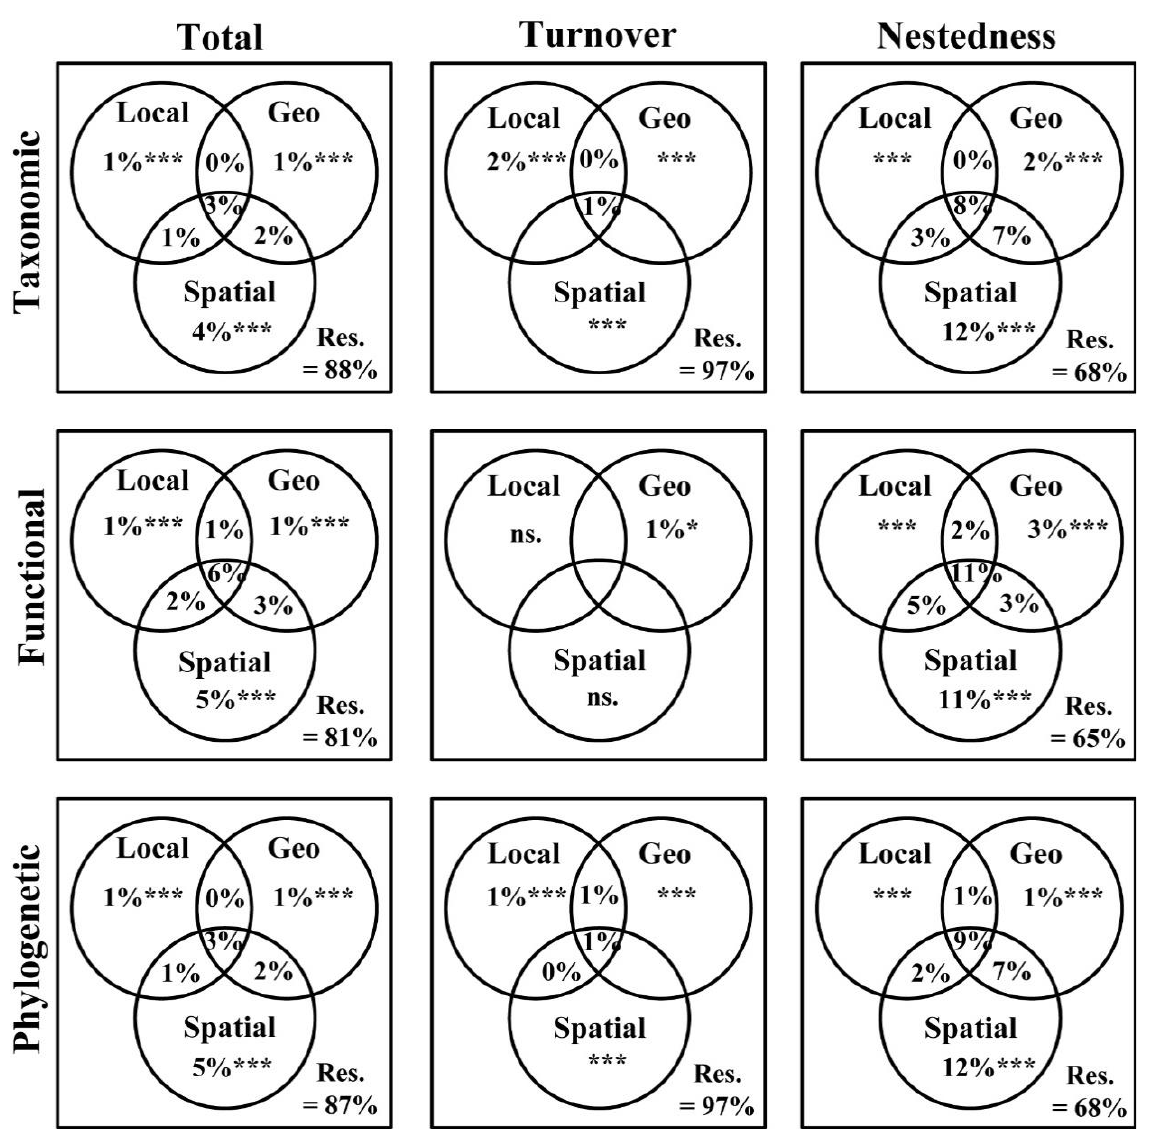
Figure 3. Relative importance of local environmental (Local), geo-climatic (Geo), and spatial (Spatial) factors on taxonomic, functional, and phylogenetic β -diversity components (i.e., total, turnover, and nestedness) of macroinvertebrates. Each set of plots indicates the pure effects of the Local, Geo, and Spatial factors on different facets and components of β -diversity (i.e., considering the effect of only one factor alone), the interaction between two variables (Local*Geo, Local*Spatial, Geo*Spatial), the joint effect of the three factors, and the unexplained effect (i.e., Res.) (total variation = 100). Values indicate the adjusted R 2 (values <0 are not shown). No significant (ns.) indicates no value for the functional turnover. Significance was indicated as *** p < 0.001, * p < 0.05.